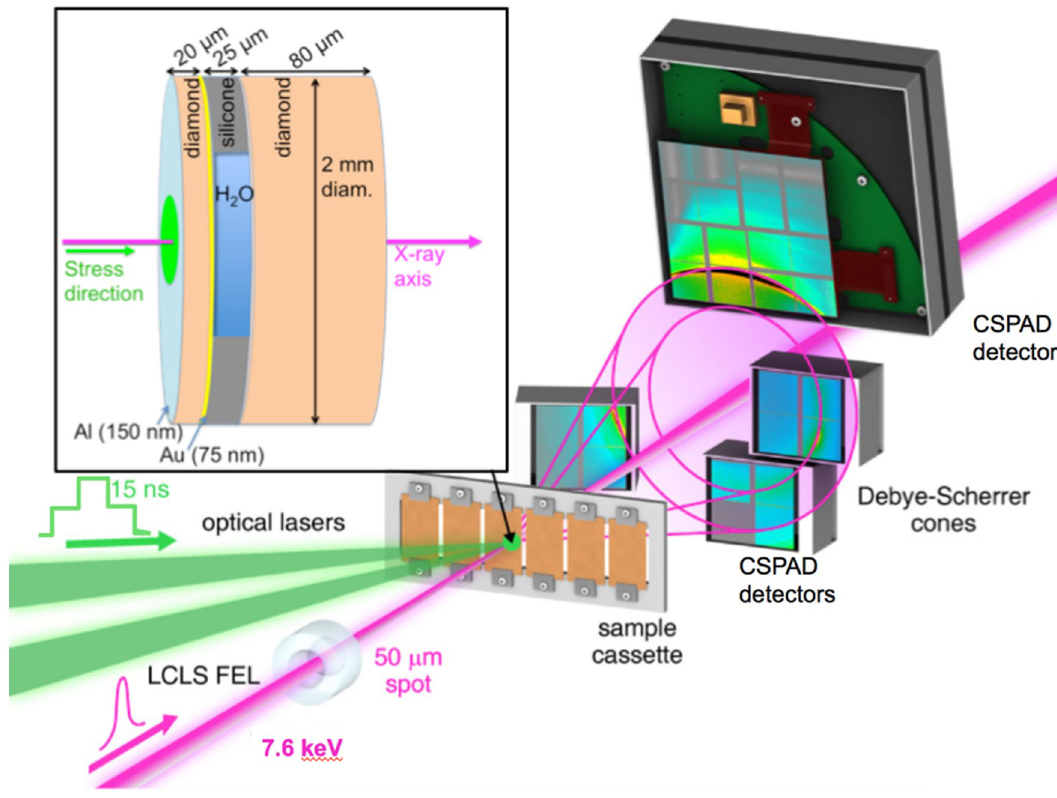
Figure 1. Experimental configuration of the XFEL probe and optical laser pump. The shock solidification behavior of water is captured in a Debye–Scherrer geometry. Inset: Schematic of target package with cut away side-view of the water